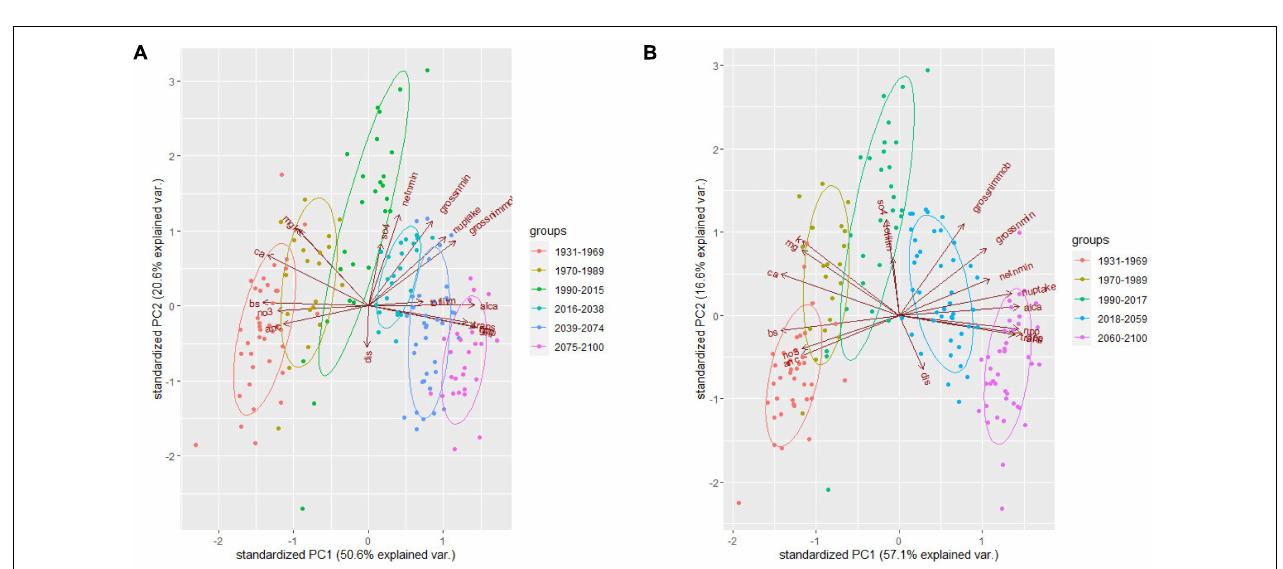
FIGURE 3 | Principal component analysis (PCA) for the 17 variables at WS18 under RCP4.5 (A) and RCP8.5 (B) . trans, transpiration; alca, ratio of Al and Ca in soil; gpp, gross primary productivity; npp, net primary productivity; nuptake, nitrogen uptake by vegetation; netnmin, net mineralization rate of nitrogen; grossnmin, gross mineralization rate of nitrogen; SO4, sulfate concentration in stream; dis, stream discharge; grossnimmob, gross immobilization rate of nitrogen; k, potassium concentration in stream; anc, acid neutralizing capacity; ca, calcium concentration in stream; mg, magnesium concentration in stream; bs, base saturation in soil; no3, nitrate concentration in stream; totlitm, total litter mass.